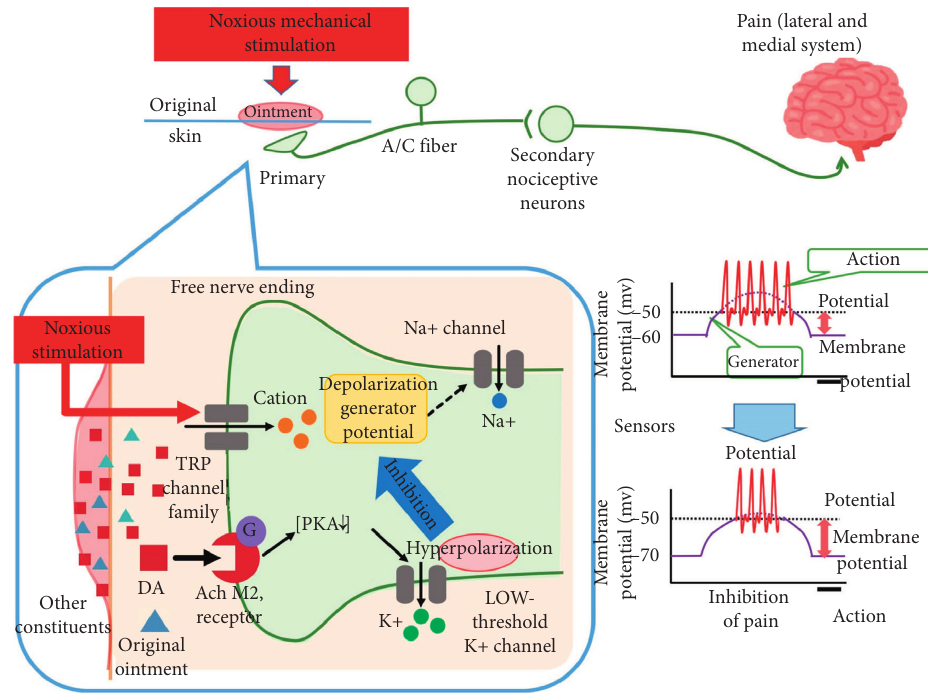
Figure 1: Mechanism of surface EMG signal